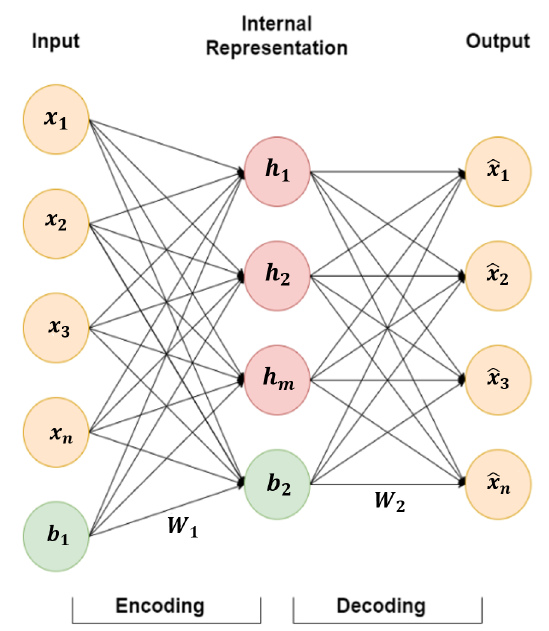
Figure 1. The AutoEncoder (AE)